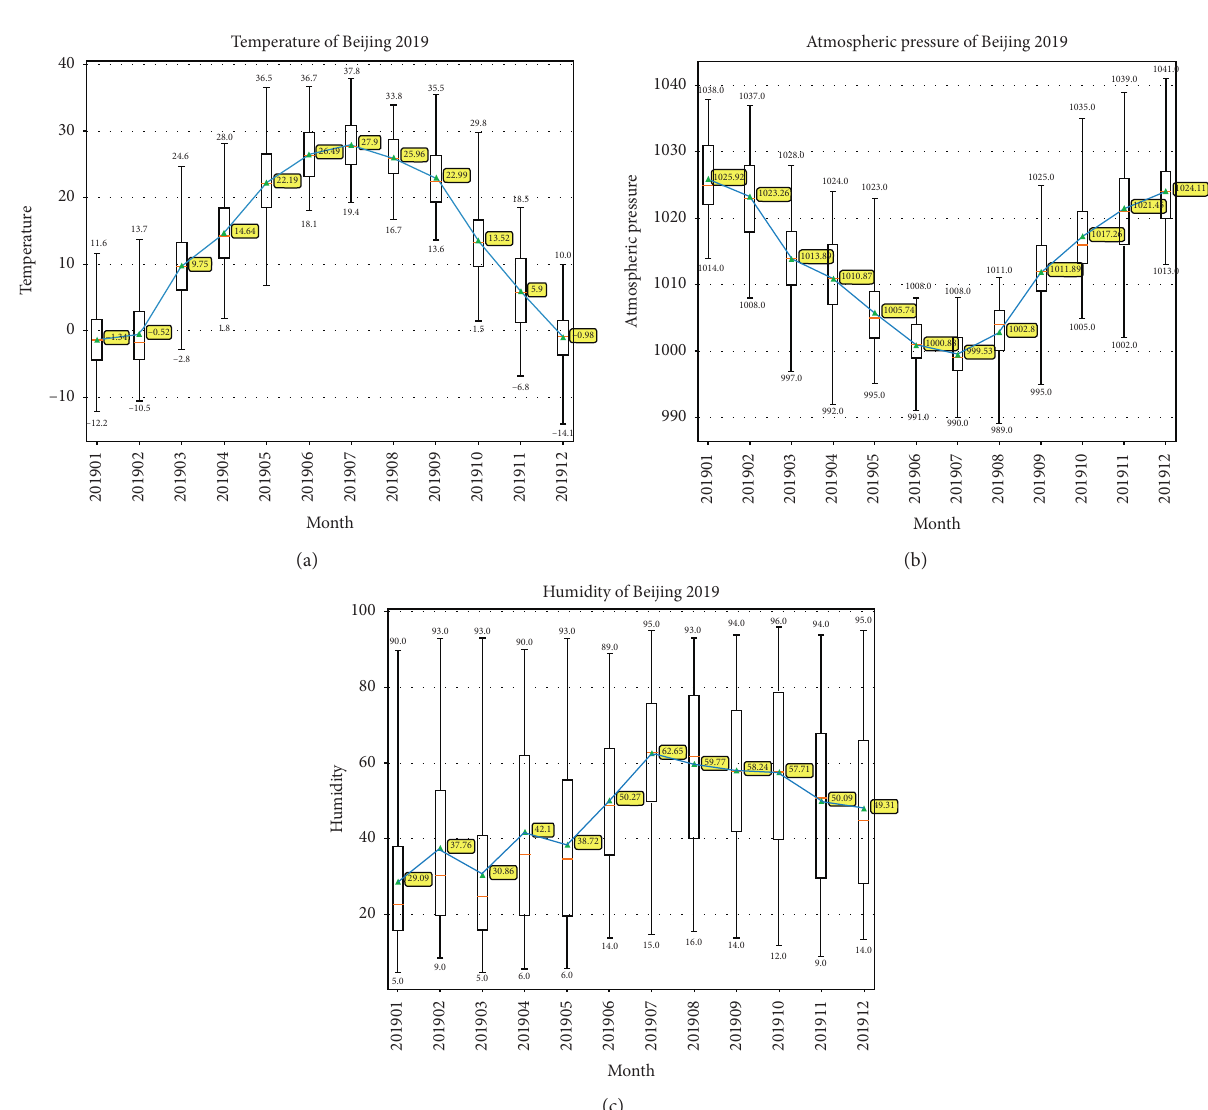
Using the method proposed in the previous section, combined with the travel speed and traffic flow (obtained through road monitors and camera videos), the traffic emissions on the experimental road section can be calcu- lated. The shaded area in Figure 15 is the 95% confidence interval. The estimated traffic emissions of the experimental sections on working days and nonworking days are shown in Figure 15. On working days, the lowest PM concentration 2.5 of road vehicles throughout the day was at 5am. After 5am, the number of vehicles on the experimental road section begins to increase, so the traffic emission of the experimental road section increases too. The PM concentration of the 2.5 experimental road section reaches the highest value at 9am. The maximum concentration of PM exceeds 70 μ g/m 3 . 2.5 Between 11am and 5pm, the PM concentration of road 2.5 stabilizes at around 40 μ g/m 3 . The PM concentration in 2.5 the evening rush hour also exceeded 60 μ g/m 3 , but it was still